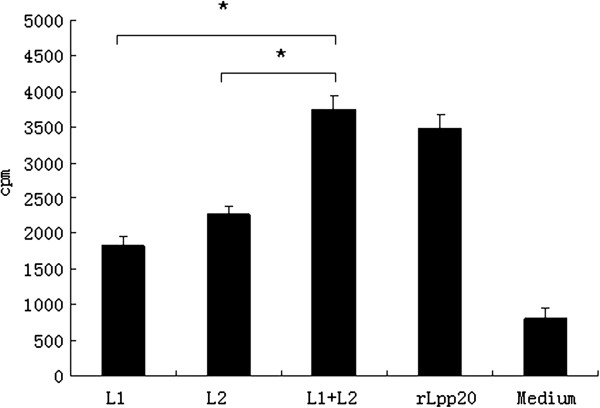
Synergistic interaction of CD4+ T cell proliferation between two epitopes. CD4+ T cells primed with rLpp20 were tested in a proliferation assay for responses to peptide L1, L2, pooled L1 and L2 (1.25 μg/ml) and rLpp20 (15 μ g/ml). Response to the antigen was expressed as the mean SI of three independent experiments ± S.D. The medium with rLpp20 was served as positive control and without any antigen weas used as negative control. The pooled peptides was significantly different from individual peptide (*p < 0.05). The values shown were means ± SD of three experiments.